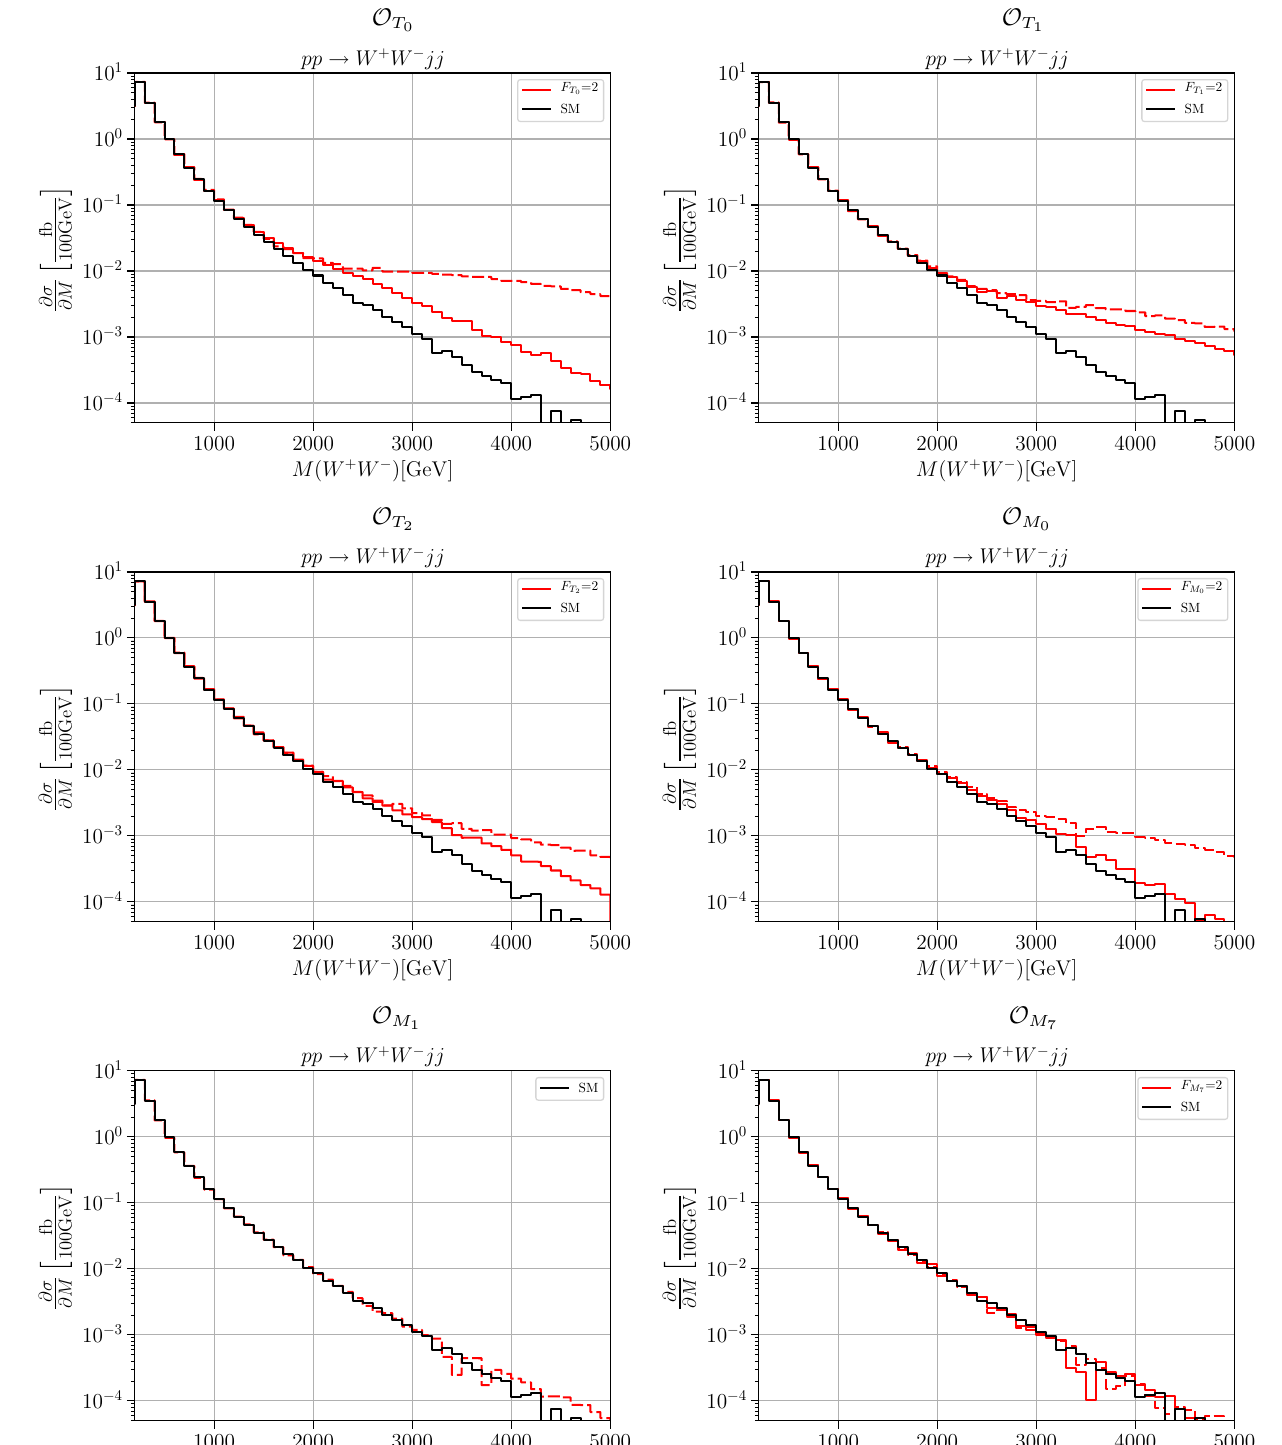
O O T 0 , 1 , 2 and M 0 , 1 , 7 (dashed: naive EFT, solid: unitarized model).